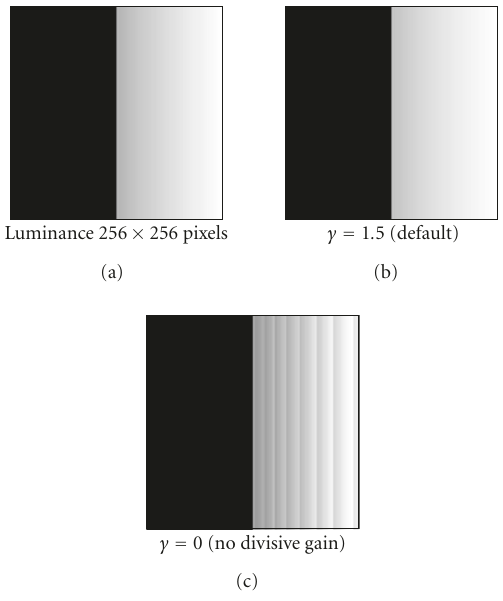
Figure 2: Artifacts with a luminance ramp. (a) The input L ij , a luminance step with a superimposed luminance ramp (increasing linearly from left to the right). (b) With the default value γ = 1 . 5 in (3), the adaptated image is correctly rendered and hardly distin- guishable from the input. (c) Setting γ = 0 causes the appearance of ripple artifacts in the adaptated image. All results are shown at t = 250